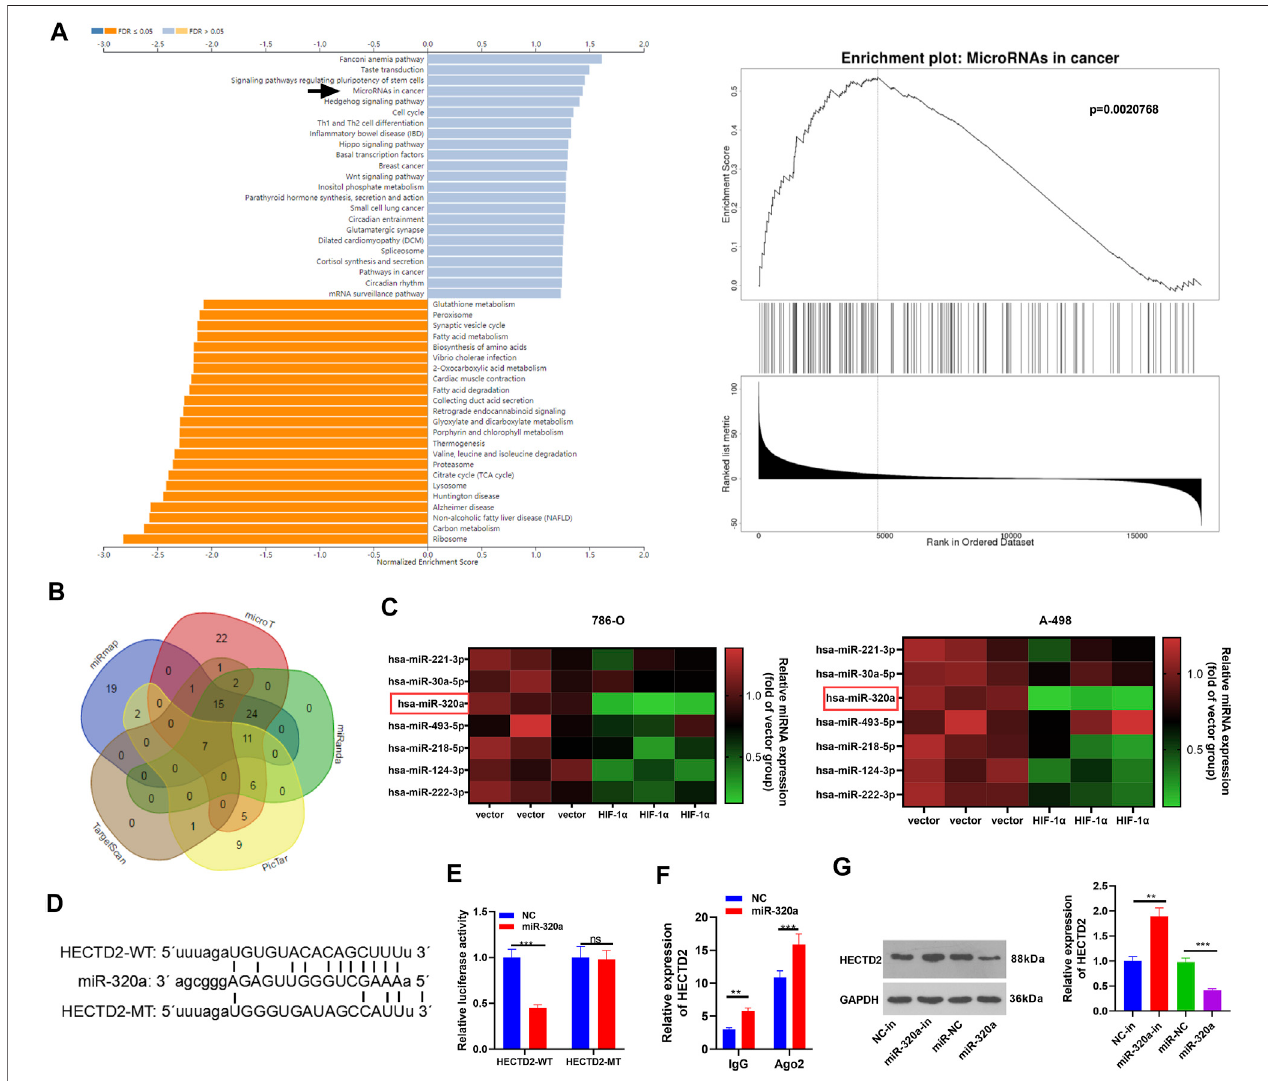
FIGURE 6 | miR-320a targeted HECTD2. (A) The positive or negative related genes of HECTD2 in TGCA database was analyzed via LinkedOmics, and those genes were subjected to GSEA enrichment analysis. HECTD2 is potentially involved in a KEGG pathway of MicroRNAs in Cancer. (B) : Targetscan, miRmap, microT, PicTar and miRanda databases were utilized to search the miRNA target of HECTD2. Venn diagram was utilized to analyze the common target miRNAs of HECTD2. Seven common miRNAs were identi fi ed, including has-miR-221-3p, has-miR-30a-5p, has-miR-320a, has-miR-493-5p, has-miR-218-5p, has-miR-124-3p and has-miR-222-3p. (C) :RT-PCRwasusedfordeterminingthesevenmiRNAs in786-Oand A-498cellstransfectedwithHIF-1 α . (D) :HECTD2 containedthebindingsites with miR-320a. (E,F) . Dual-luciferase reporter assay and RIP assay were applied to probe the binding of miR-320a to HECTD2. G: HECTD2 level in 786-O cells transfected with miR-320a mimics or miR-320a inhibitors was tested by WB. NS p > 0.05, **p < 0.01, ***p < 0.001 . N (cid:2) 3.